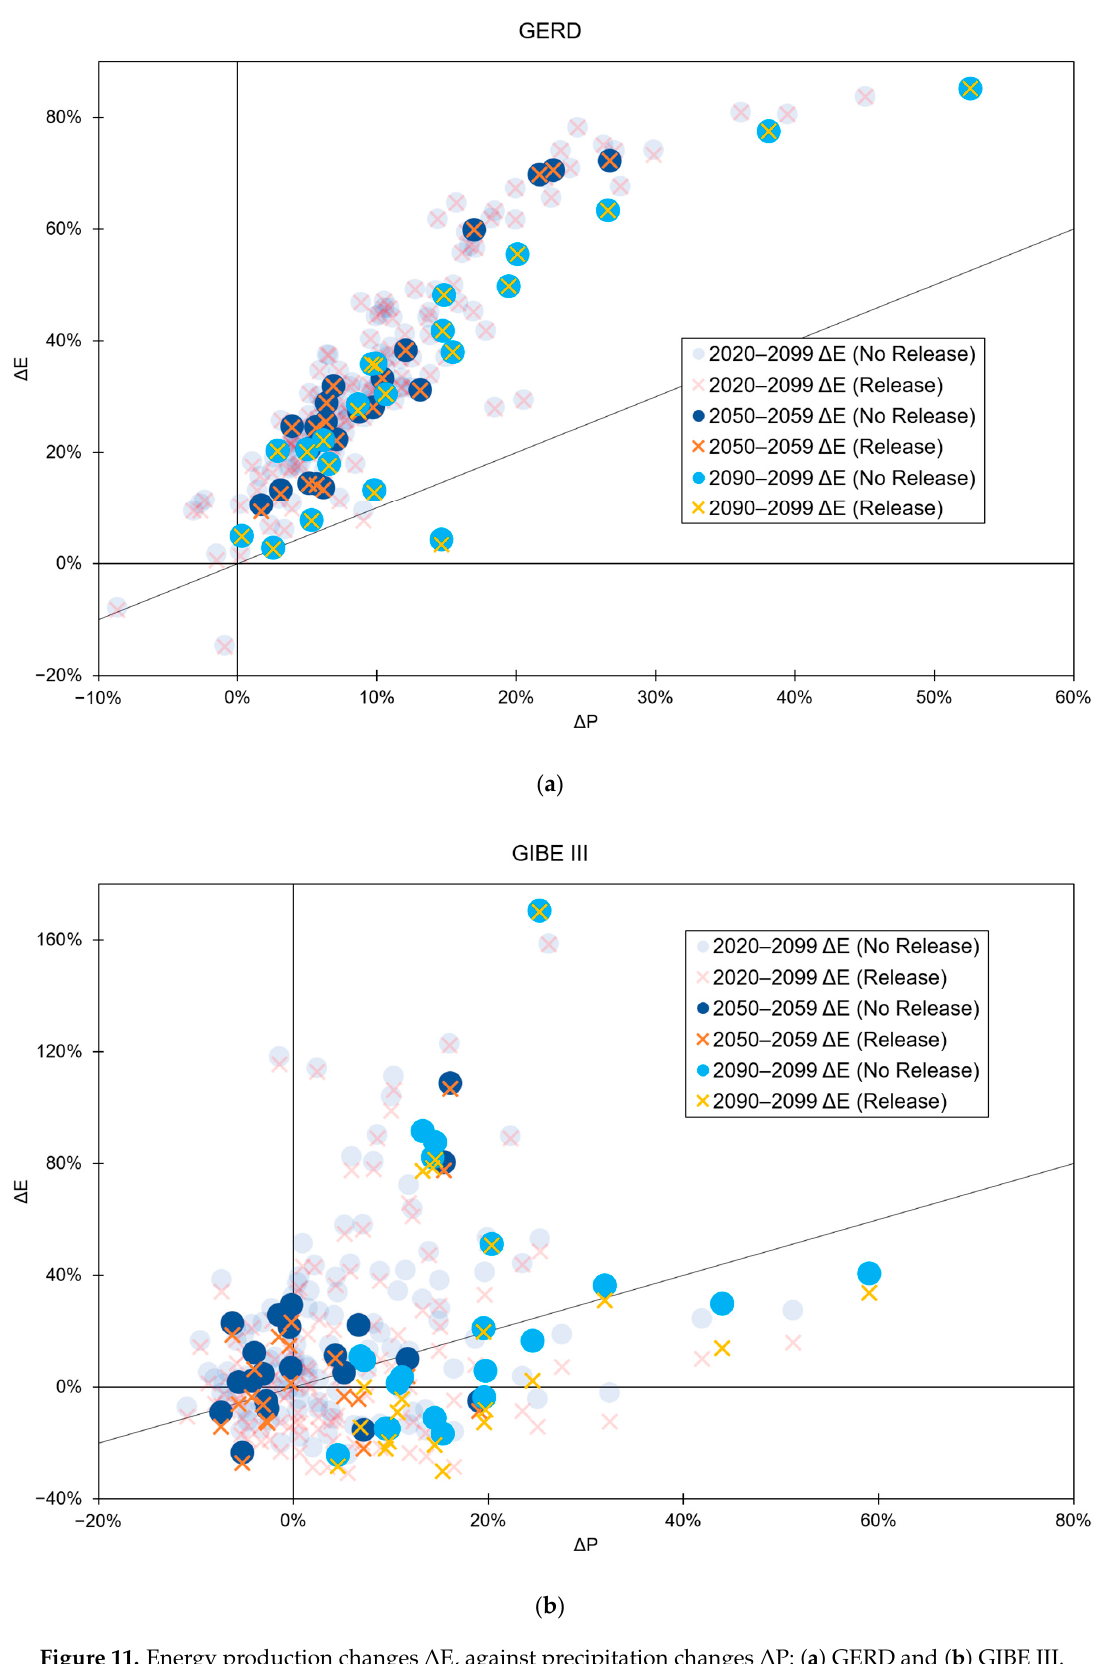
Figure 11. Energy production changes ∆ E, against precipitation changes ∆ P: ( a ) GERD and ( b ) GIBE